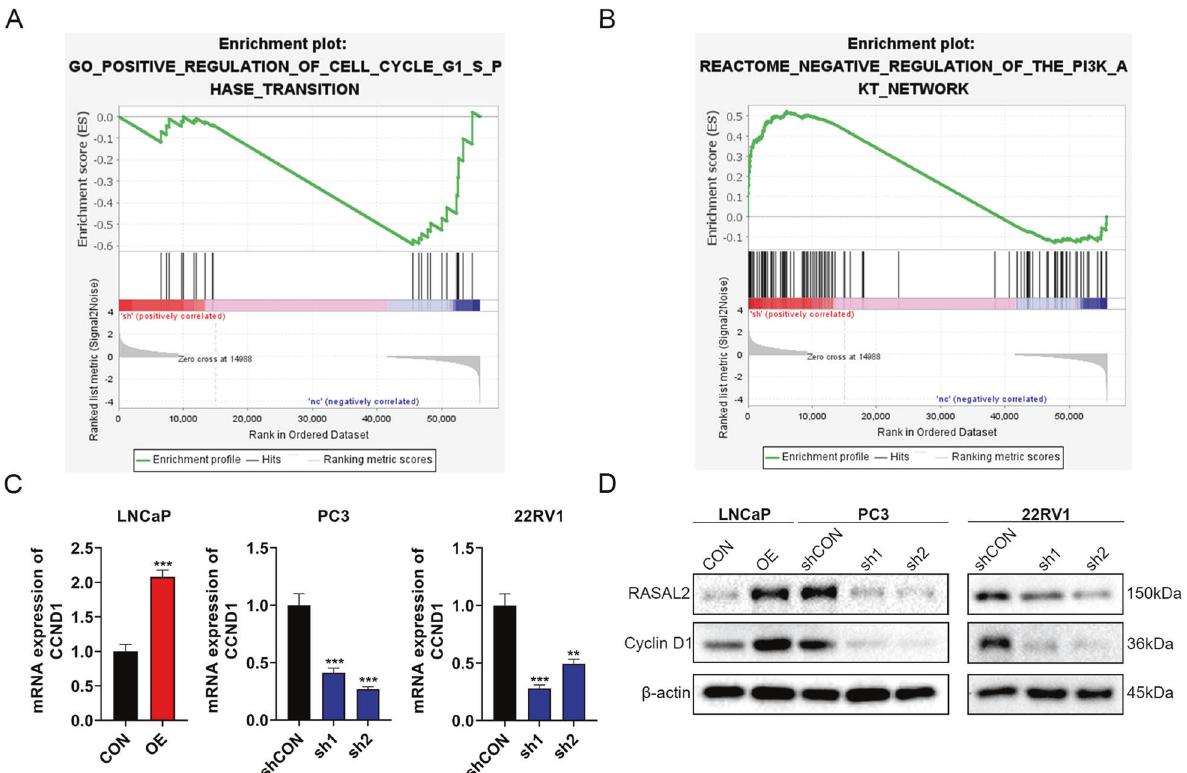
Fig. 3 Effect of RASAL2 on the PI3K/AKT pathway and cyclin D1 (CCND1) expression. A , B GSEA for RNA sequencing of PCa sublines with RASAL2 knockdown. C , D Quantitative real-time RT – PCR and Western blotting analysis of CCND1 mRNA expression in established cell